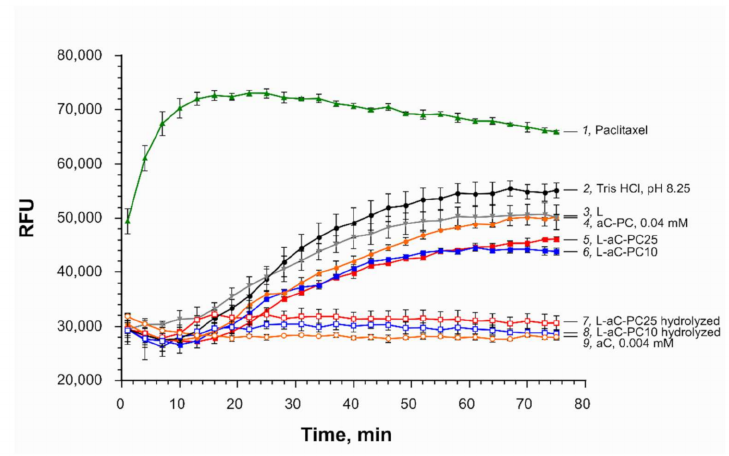
Figure 5. Tubulin polymerization assay. Effect of various liposomal samples on tubulin aggregation at 34 µ M in tubulin polymerization buffer at 37 ◦ C: 1 , paclitaxel, 3 µ M, polymerization enhancer control (green triangles); 2 , Tris-HCl, pH 8.25, buffer (black circles); 3 , L, 0.4 mM total lipids (negative control; gray reversed triangles); 4 , aC-PC, 40 µ M (orange filled circles); 5 , L-aC-PC25 (100 µ M aC-PC; red filled squares); 6 , L-aC-PC10 (equivalent to 40 µ M aC-PC; blue filled squares); 7 , L-aC-PC25 (100 µ M aC-PC) hydrolyzed to aC (red empty squares); 8 , L-aC-PC10 (40 µ M aC-PC) hydrolyzed to aC (blue empty squares); 9 , aC, 4 µ M (orange empty circles). Mean ± SE are reported. n = 3. For sample designations, see Table